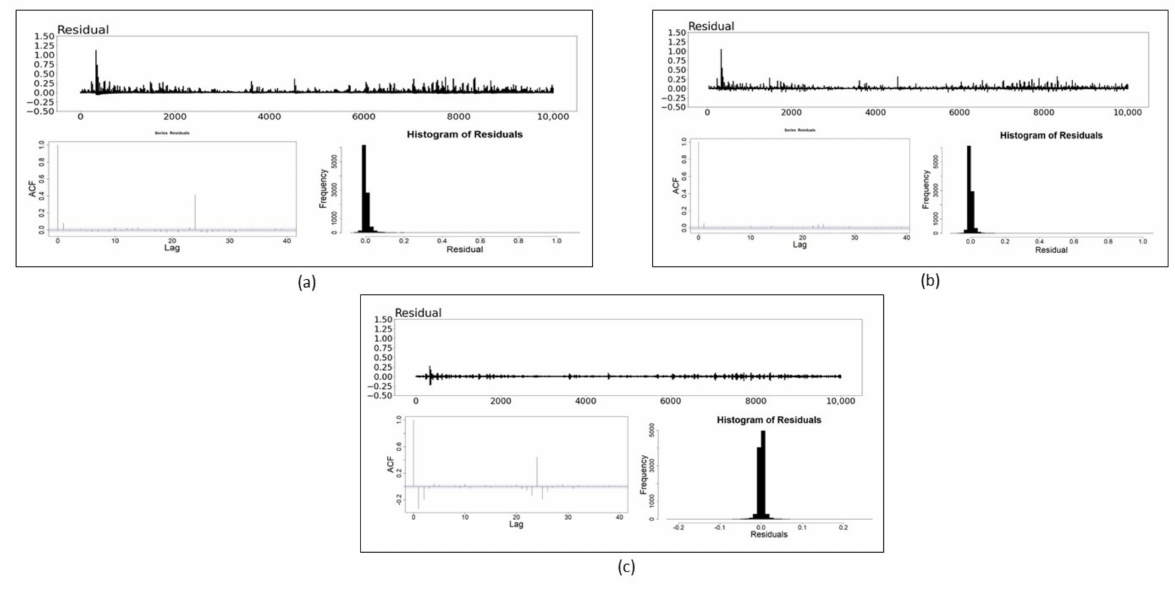
Figure 4. Residual plots, ACF plots and histograms of the: ( a ) GARCH(1,1) model; ( b ) NN model and ( c ) SS model for Bitcoin. The blue dotted lines in ACF plots indicate the point of statistical